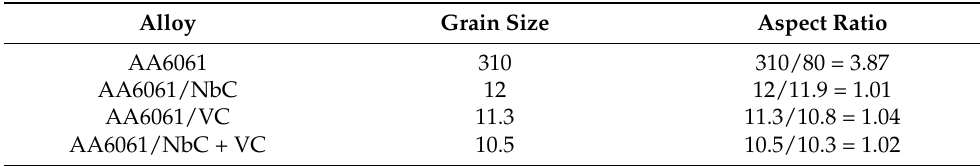
Table 2. Microstructure grain size inside the stirred